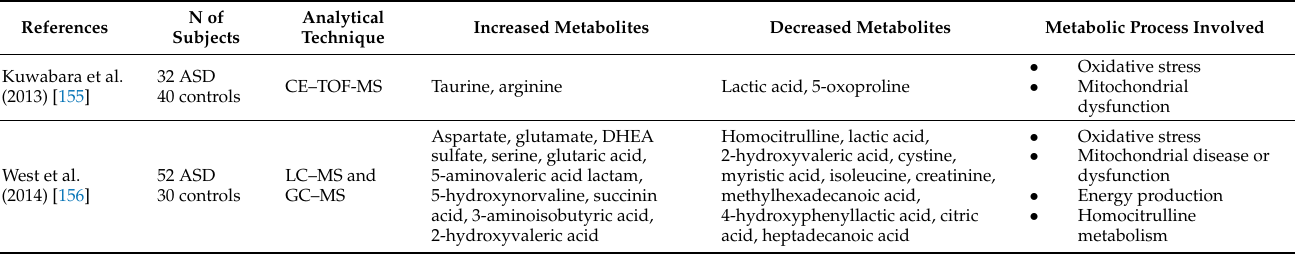
Table 1. Metabolites in blood samples of ASD subjects from metabolomic